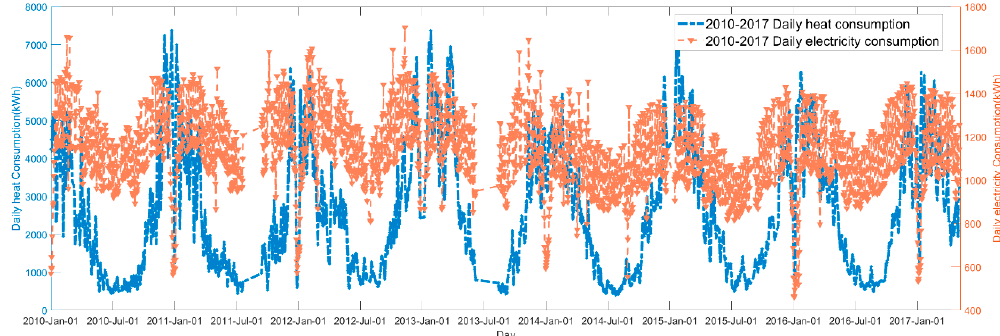
Figure 3. Jan 2010–Apr 2017 daily heat and electrical energy consumption (kWh).